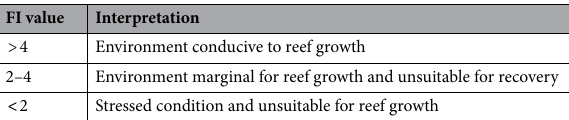
Table 2. The values and interpretation of FORAM index (FI) 11 .